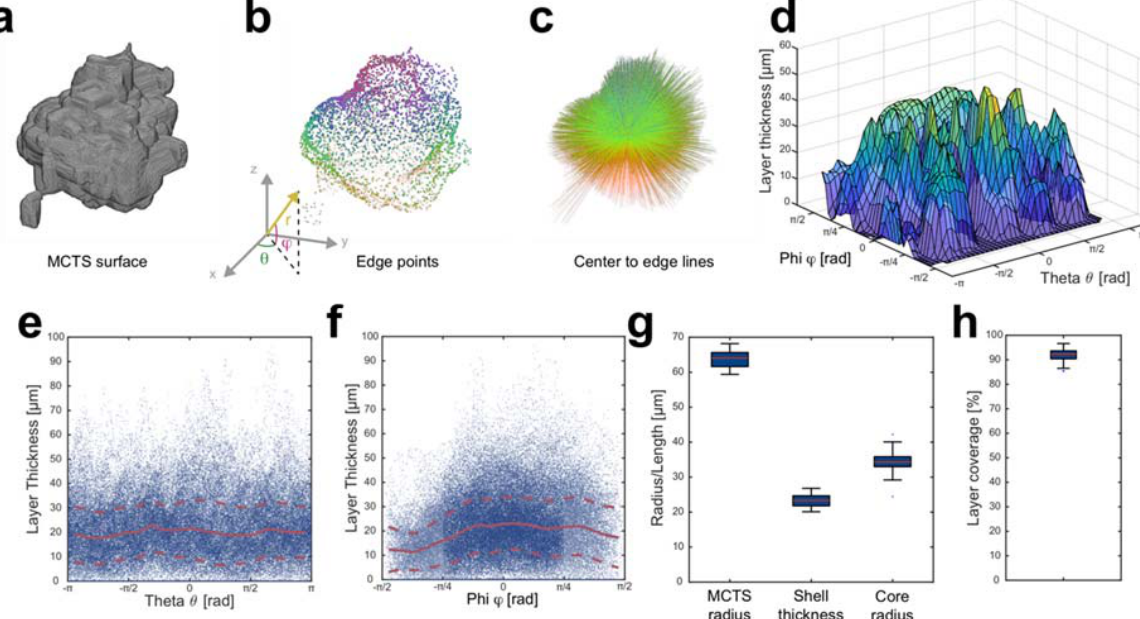
Figure 4. Center to edge line-analysis assessing direction dependent MCTS core and shell thickness distribution. Using the core-shell MCTS surface ( a ), 5000 equidistantly spaced points were defined on each MCTS by using spherical coordinates (radial distance r , polar angle ϕ [ − π /2 ≤ ϕ ≤ π /2] and azimuth angle θ [ − π ≤ θ ≤ π ]) with the origin placed in the MCTS core center point ( b ). The voxels along the lines between the MCTS core center and each edge point ( c ) were evaluated in the segmented Far Red volume to acquire the shell thickness (number of Far Red positive voxels times length per voxel) as a function of the polar and azimuth angle in each MCTS ( d ). The color of the points and lines corresponds to the position along the z -axis ( b , c ). Line data points (blue dots) pooled from all (n = 20) core-shell MCTSs shows the shell thickness distribution as a function of azimuth ( e ) and polar angle ( f ). The mean (solid red line) and standard deviation (dashed red line) were calculated in π /10 ( e ) and π /20 ( f ) wide angle segments for the azimuth and polar angle respectively. The line data were used to measure the average MCTS radius, shell thickness and inner core radius in each MCTS ( g ). All lines not including any Far Red positive voxels were used to measure the shell core coverage percentage ( h ). Boxplots show the 25th and 75th percentiles with a red line marking the median value. The whiskers show the furthest observation 1.5 times the interquartile length away from the box edge while outliers are marked with a blue